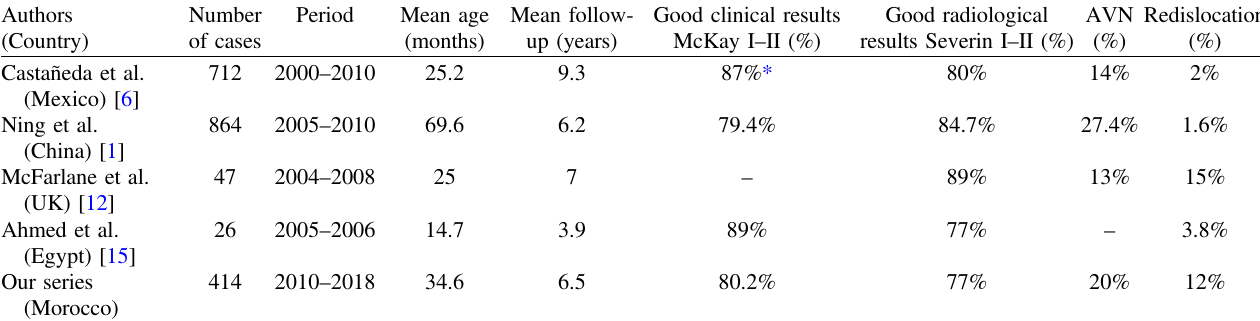
Table 5. Outcomes of other series of